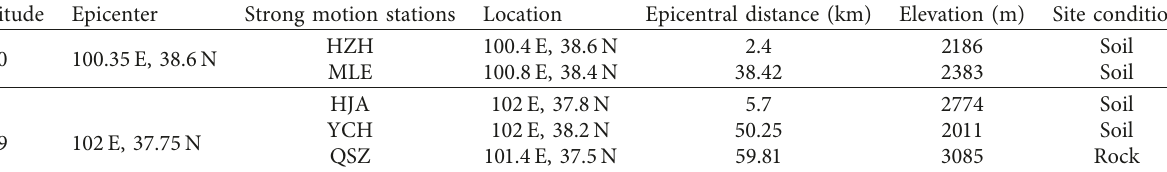
Table 1: Details about each strong motion station.